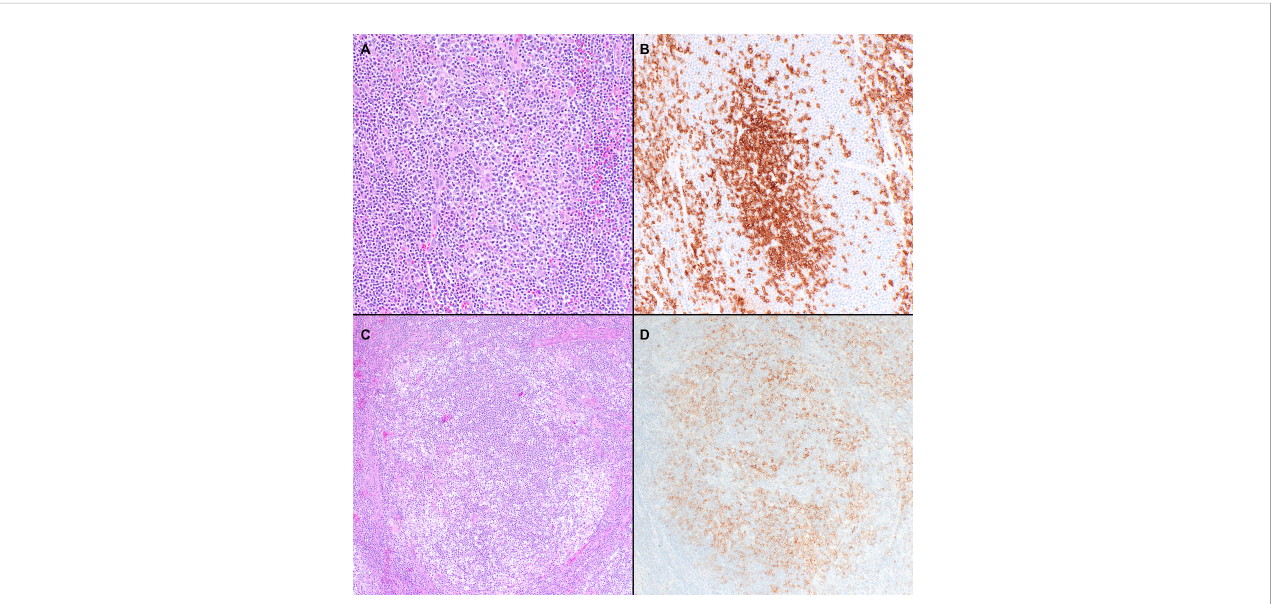
FIGURE 2 Histopathologic features of nodal T-follicular helper (TFH) cell lymphoma, follicular-type. (A) This case shows a predominantly follicular growth pattern, simulating follicular lymphoma, with the neoplastic follicles composed of small to medium-sized atypical lymphocytes admixed with scattered large cells (20x); (B) PD-1 shows that the tumor cells form solid clusters inside the nodules with residual B-cells pushed to the periphery of the follicles (not shown) (20x); (C) This other case shows that the neoplastic nodules have features of progressive transformation of germinal centers (PTGC). The nodules display a ‘ moth-eaten ’ appearance with aggregates of neoplastic T-cells surrounded by small B-cells (20x); (D) The neoplastic cells are positive for PD-1 in addition to other TFH markers (not shown)